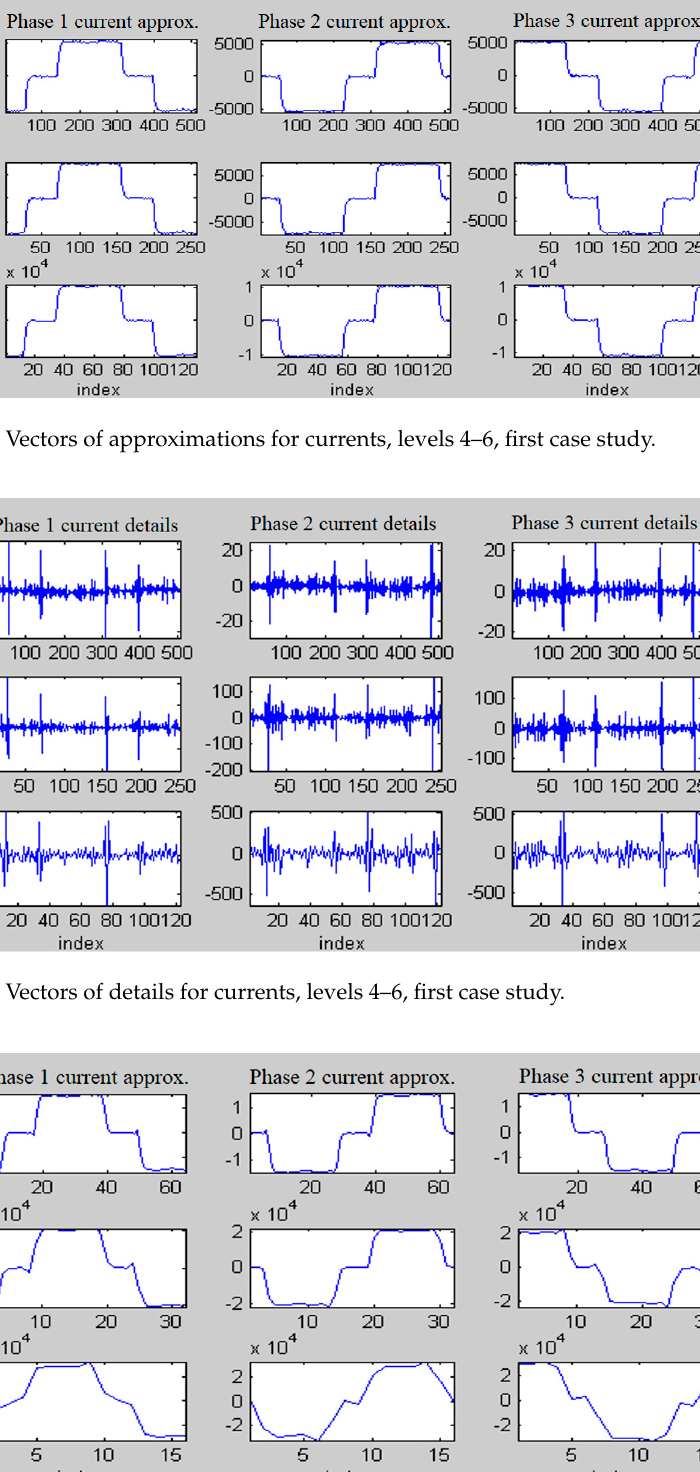
Figure 14. Vectors of details for currents, levels 1–3, first case study.